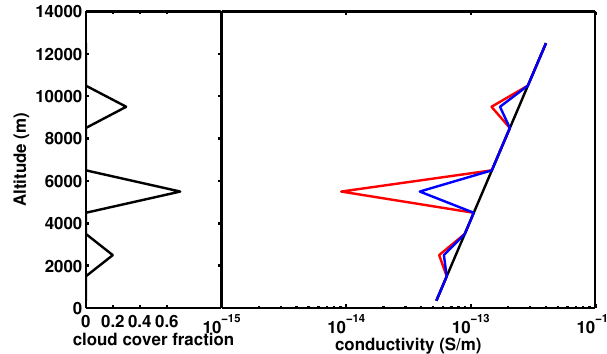
Figure 6. Left: cloud cover fraction of a single column. Right: back- ground (black), ZT10 (blue) and parameterized (red, see text) cloud conductivity